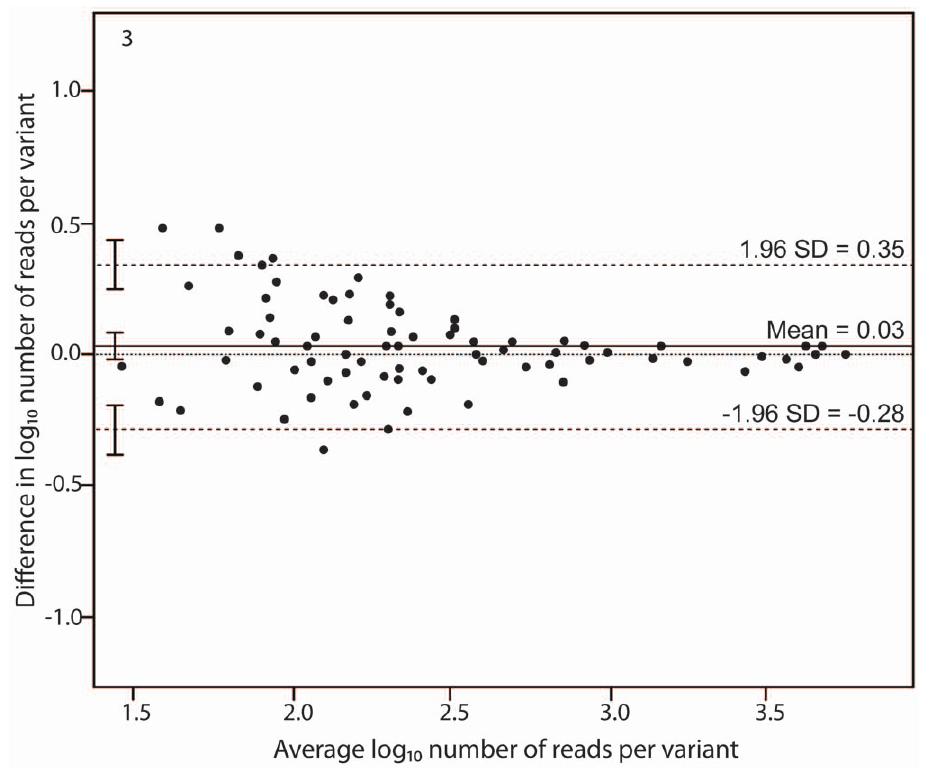
Figure 3. Bland-Altman plot showing the agreement of variant quantification in forward and reverse direction. The data from the paired measurements from sample A and sample B were combined and the number of reads in the reverse direction was weighted by the number of reads in the forward direction. The number of reads per variant was log transformed. The differences in number of reads per variant in forward and reverse direction are plotted against the average number of reads per variant. Horizontal lines are drawn at the mean difference between the two measurements and at the upper and lower limits of agreement. The 95% confidence intervals are also shown for the mean and the upper and lower limits of agreement.